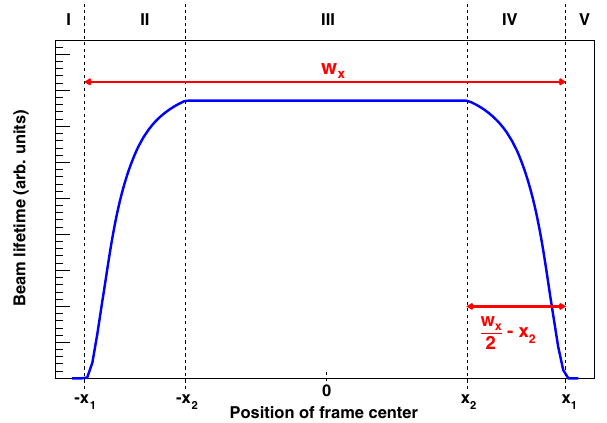
FIG. 19. Schematic of the beam lifetime as a function of the position of the frame during an acceptance measurement. As long as the frame is outside the machine acceptance (part III), the beam lifetime is unchanged. When the frame limits the acceptance the beam lifetime drops (parts II and IV) according to (31), and when it intersects the beam itself, the beam lifetime vanishes (parts I and V). The acceptance is then defined by the frame width w the position where the frame enters the machine acceptance x 2